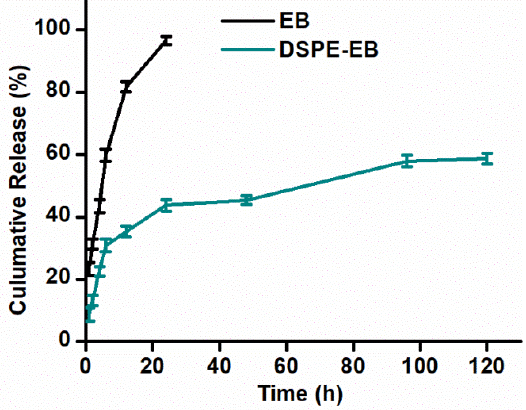
Figure 4. Sustained release curve of EB and DSPE-EB in 40% ethanol.